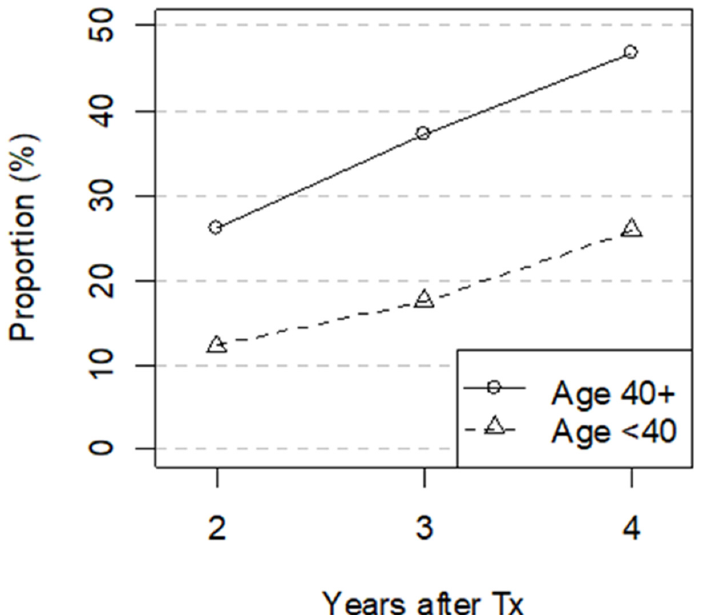
Figure 4. Proportion (%) of patients with no statin dispensed the first year after transplantation who initiated with statins within 2-, 3- and 4 years after Tx in the age groups <40 and ≥ 40 years. The denominator is those still alive 2, 3 and 4 years after transplantation, respectively. Tx–transplantation. Of the 1467 patients who had the first Tx between 2005–2012 and were alive four years after Tx, 250 (17%) did not receive a statin the first four years after